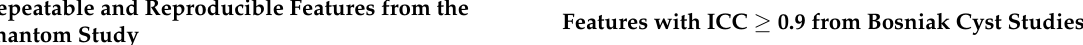
Table 5. Repeatable and reproducible radiomic features from the phantom study and features with an Intraclass Correlation Coefficient (ICC) equal to or greater than 0.90%. Coincident features between phantom study and ICC study are